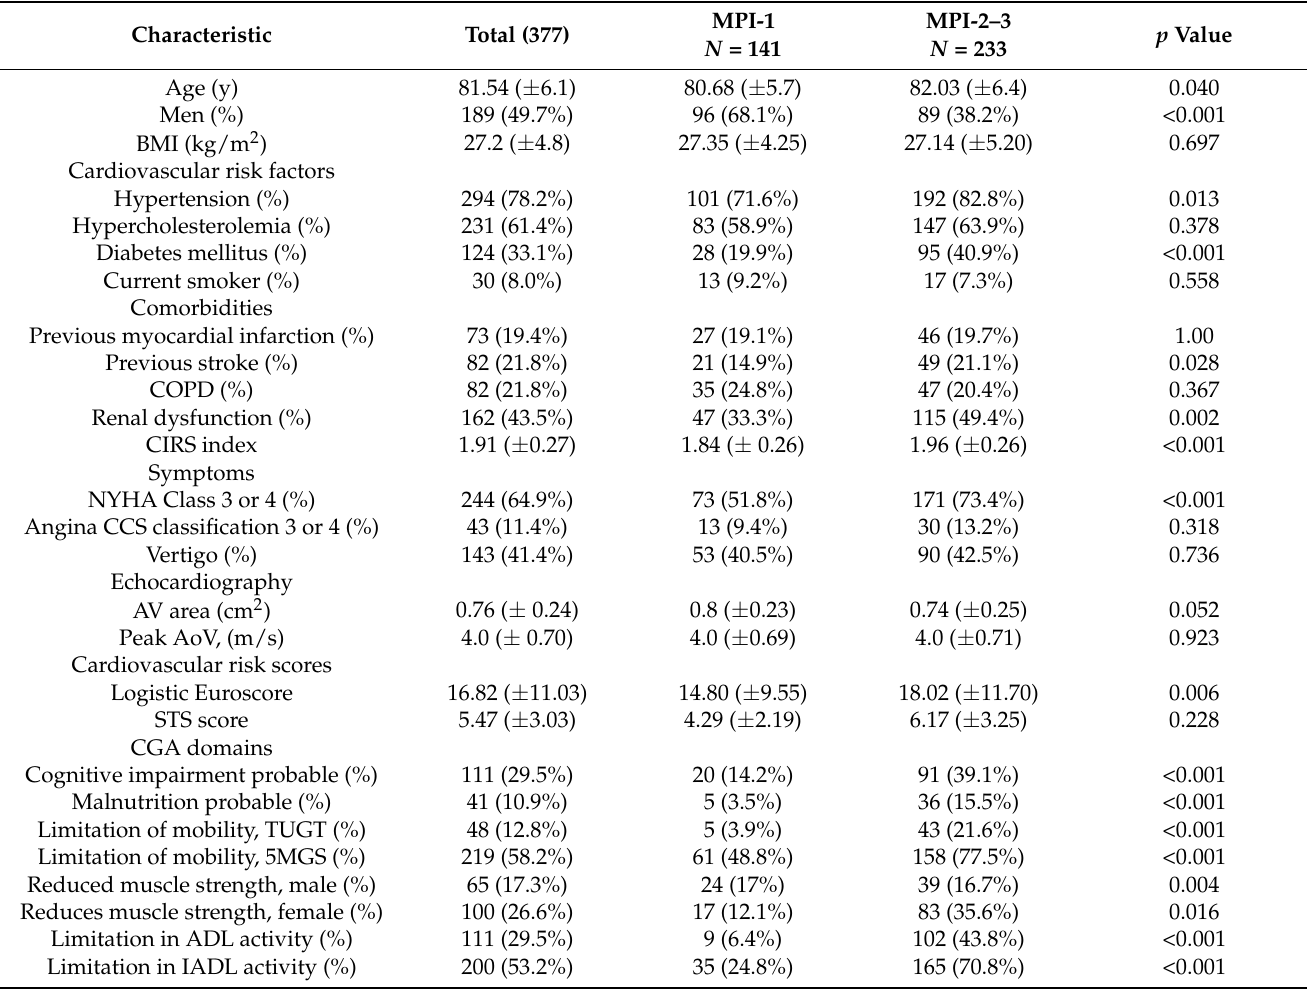
Table 2. Baseline patient characteristics ( n =